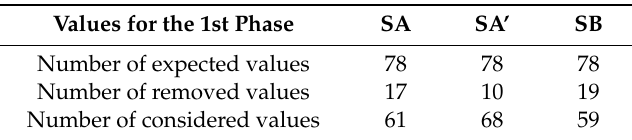
Table 1. Numbers of expected, removed and considered values for the data curation and statistical analysis of the first